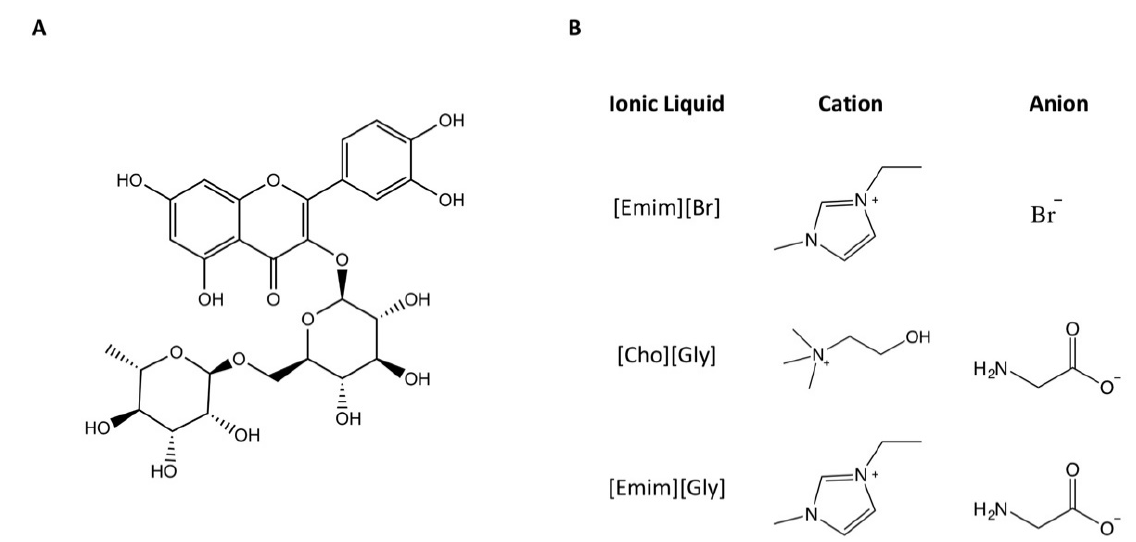
Figure 1. Chemical structures of rutin ( A ) and the studied ionic liquids ( B ).